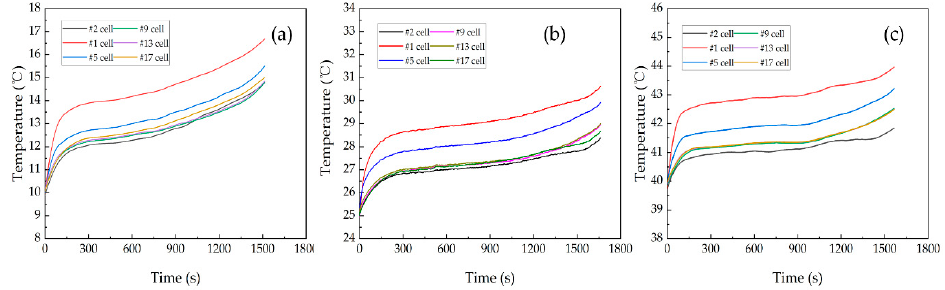
Figure 8. The change of ba tt ery module temperature with discharge time at di ff erent coolant tem- peratures: ( a ) 10 °C [31], ( b ) 25 °C [31], ( c ) 40